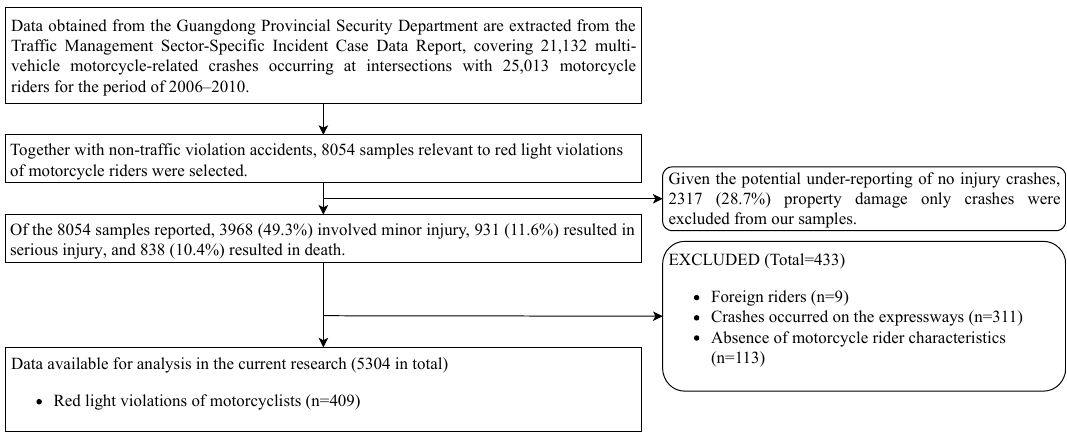
Figure 1. Data flow diagram for analysis of crashes caused by motorcyclists running red lights.